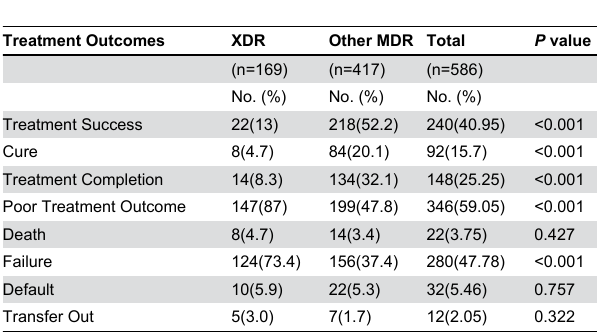
Table 4. Treatment Outcomes of patients with XDR-TB and Other